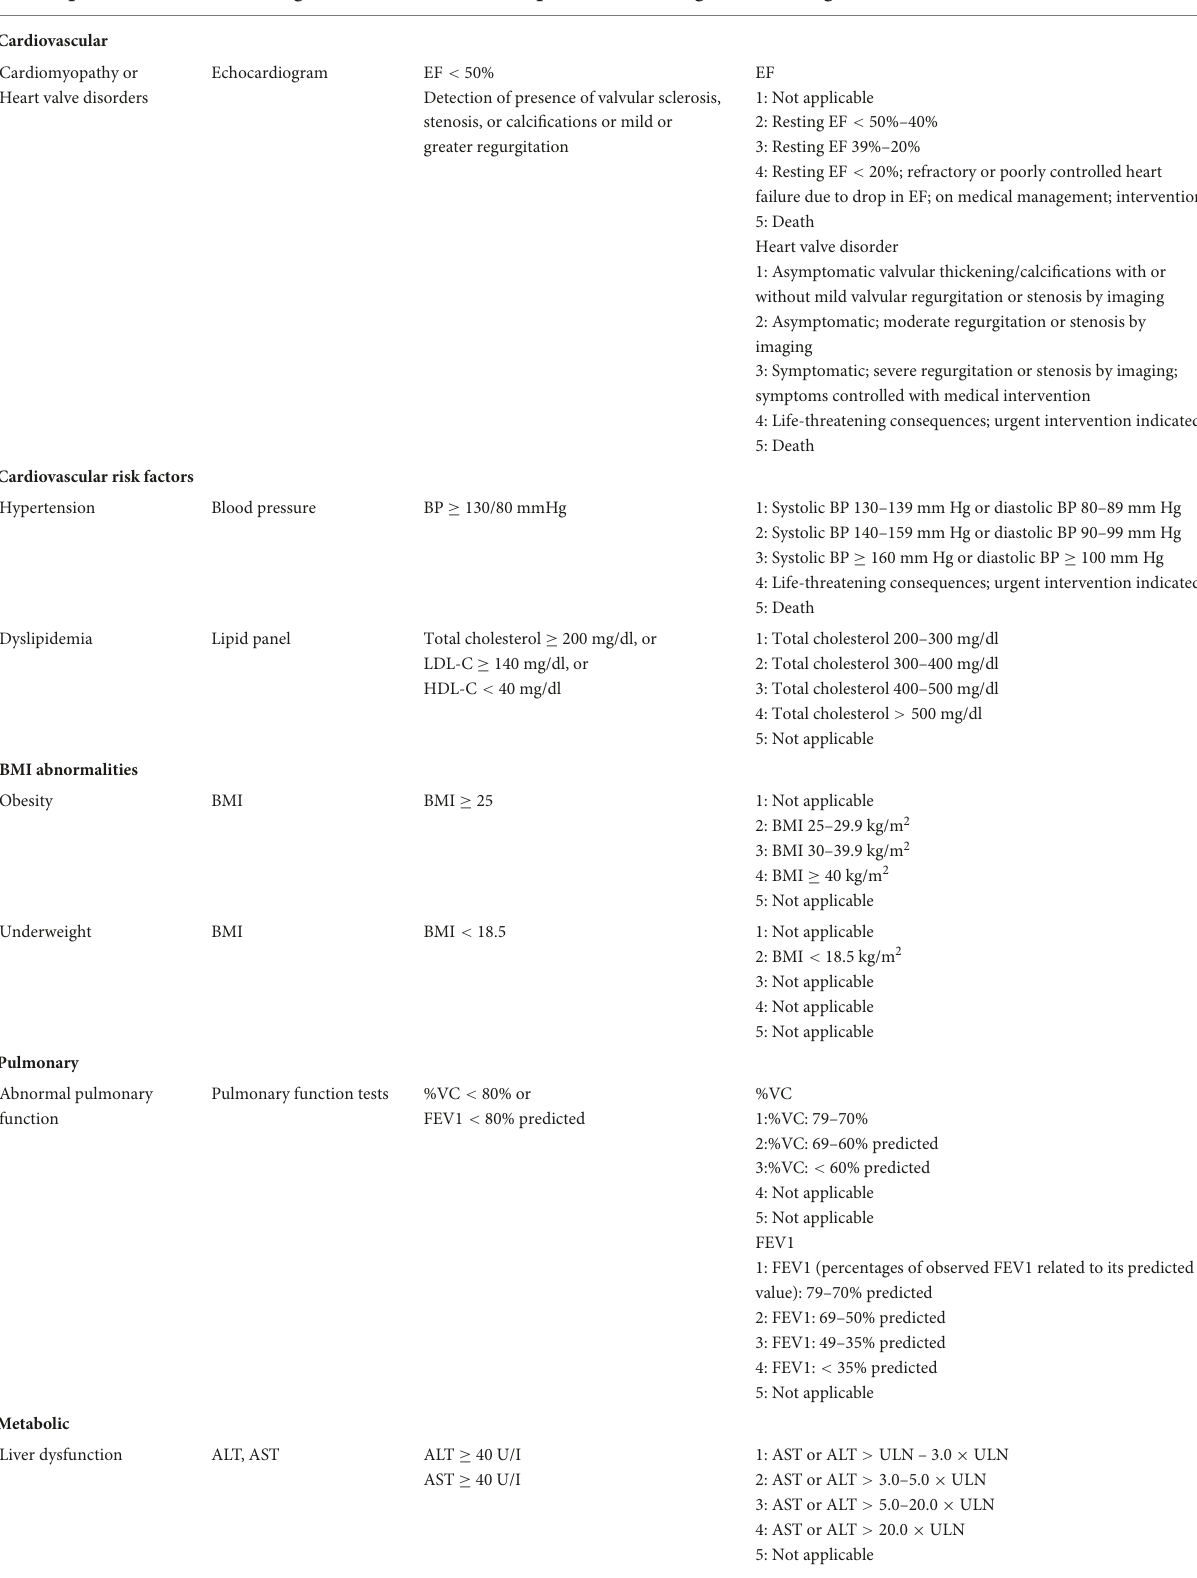
TABLE 1 Definition of health problems, screening tests, criteria for positive screening, and grading rubric. Health problem Screening